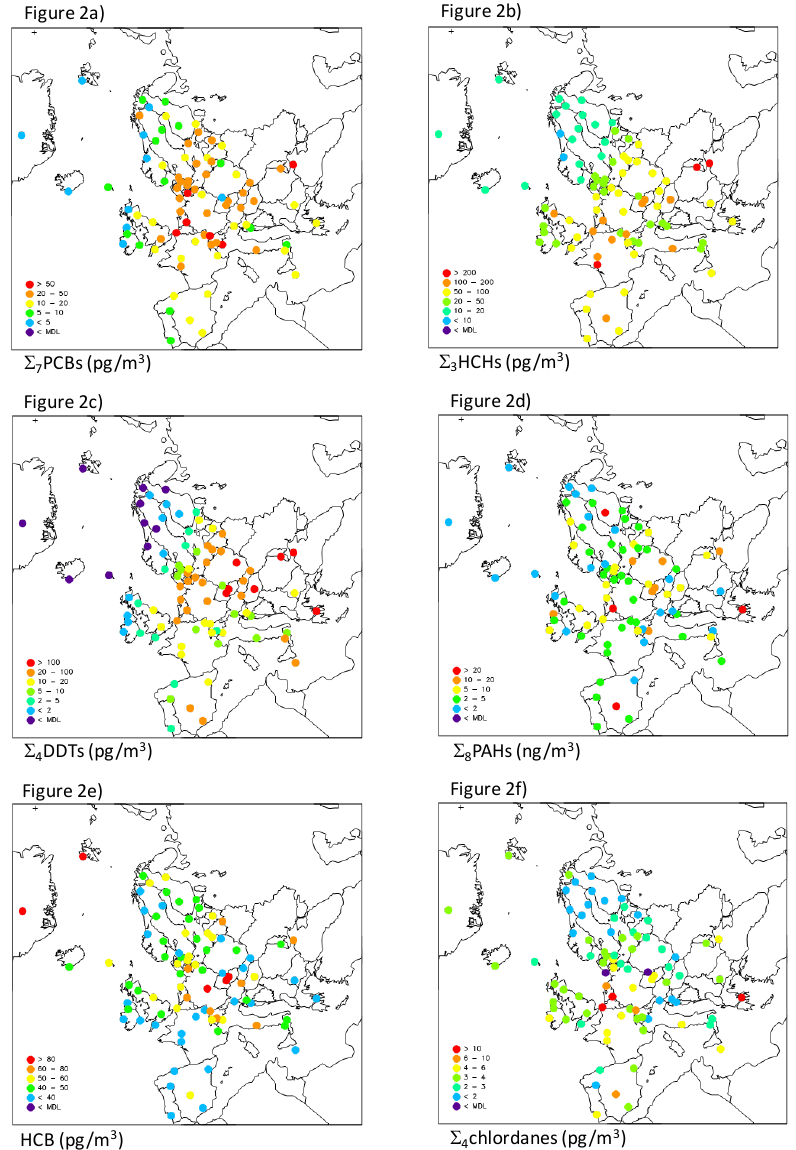
Fig. 2. (a) – (f) : Spatial patterns of 6 7 PCBs, 6 3 HCHs, 6 4 DDTs, 6 8 PAHs, HCB and 6 4 chlordanes in European background